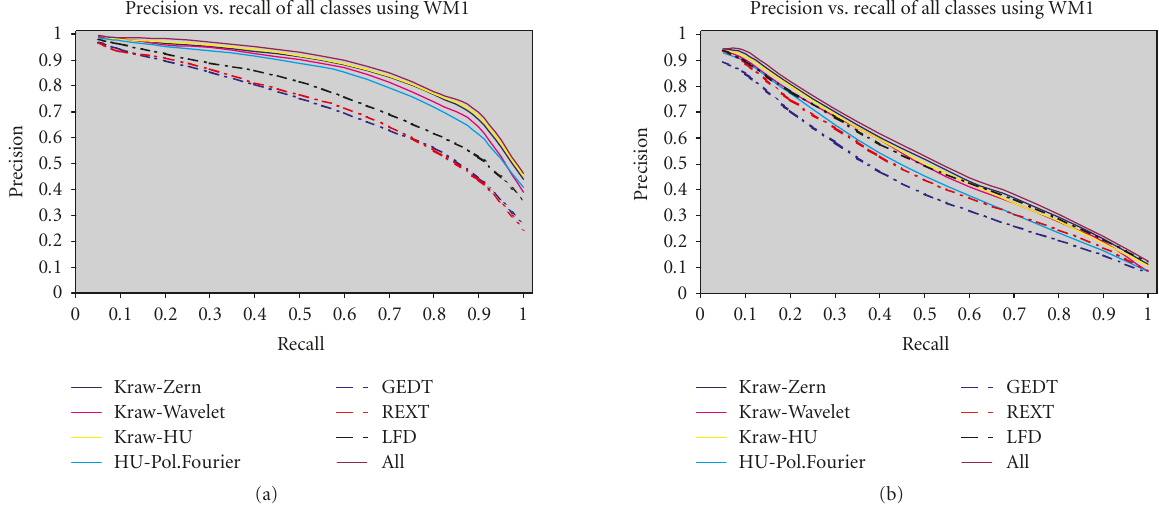
Figure 8: Precision-recall curves diagram some of the best descriptor vector combinations, using the weight method 1 for the new database (a) and for the Princeton database